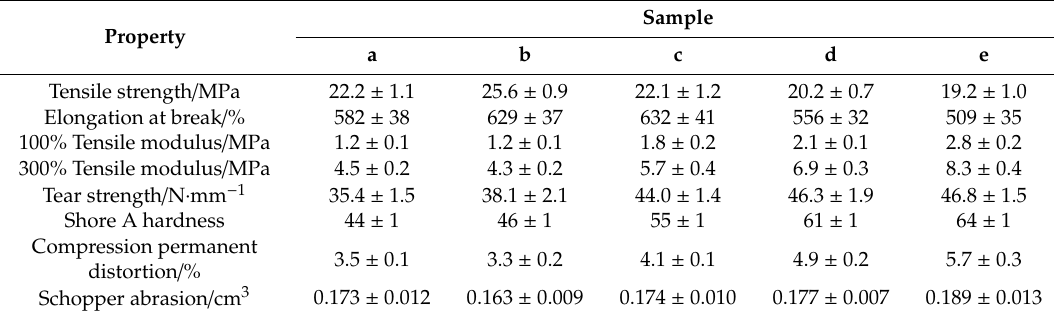
Table 3. Physical and mechanical properties of SSC@NR